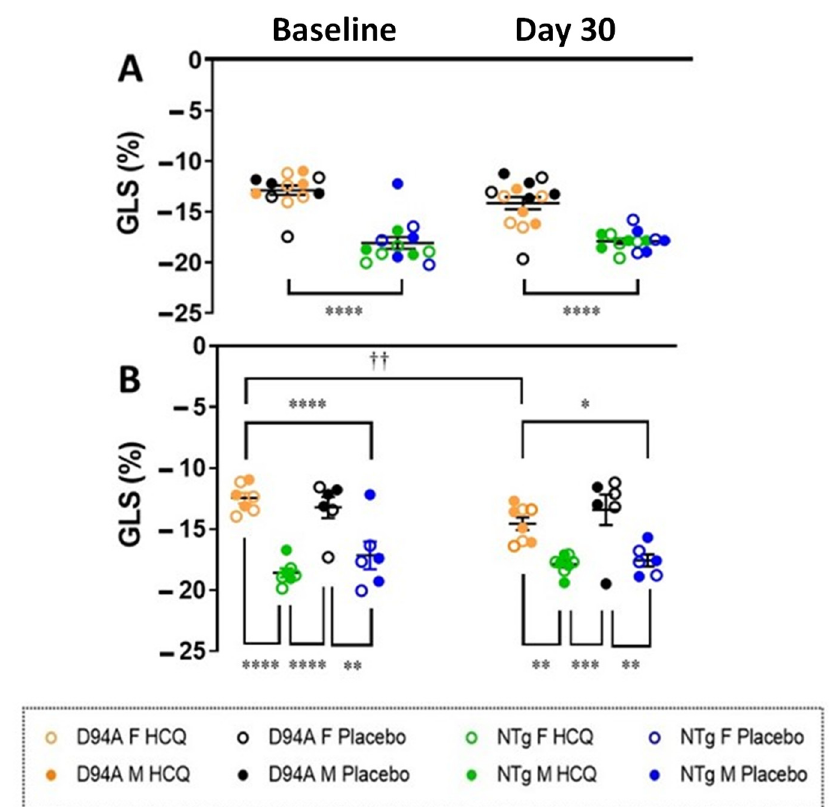
Figure 3. Cardiac performance of Tg-D94A vs. NTg mice assessed by speckle-tracking echocardiog- raphy. Top panel ( A ) shows pooled values of global longitudinal strain (GLS) from Tg-D94A vs. NTg groups at baseline and 30 days after treatment with HCQ or placebo (H 2 O), indicating an impaired cardiac function in the Tg-D94A group. The bottom panel ( B ) depicts GLS for each group and the effect of HCQ treatment over time. Data are presented as mean ± SEM of n = N o animals (shown in Table 1), with significance calculated by unpaired t -test ( A ) and mixed-effects analysis followed by Sidak’s multiple comparisons test ( B ). Significance is denoted with * p < 0.05, ** p and †† p < 0.01, *** p < 0.001, and **** p < 0.0001. Asterisks (*) depict significant differences between Tg-D94A and NTg mice (±HCQ) and crosses ( † ) the differences between the values for Tg-D94A at baseline and after 30 days of HCQ treatment. Table 1. Doppler echocardiographic evaluation of Tg-D94A and NTg mice at baseline and 30 days after treatment with HCQ or placebo.